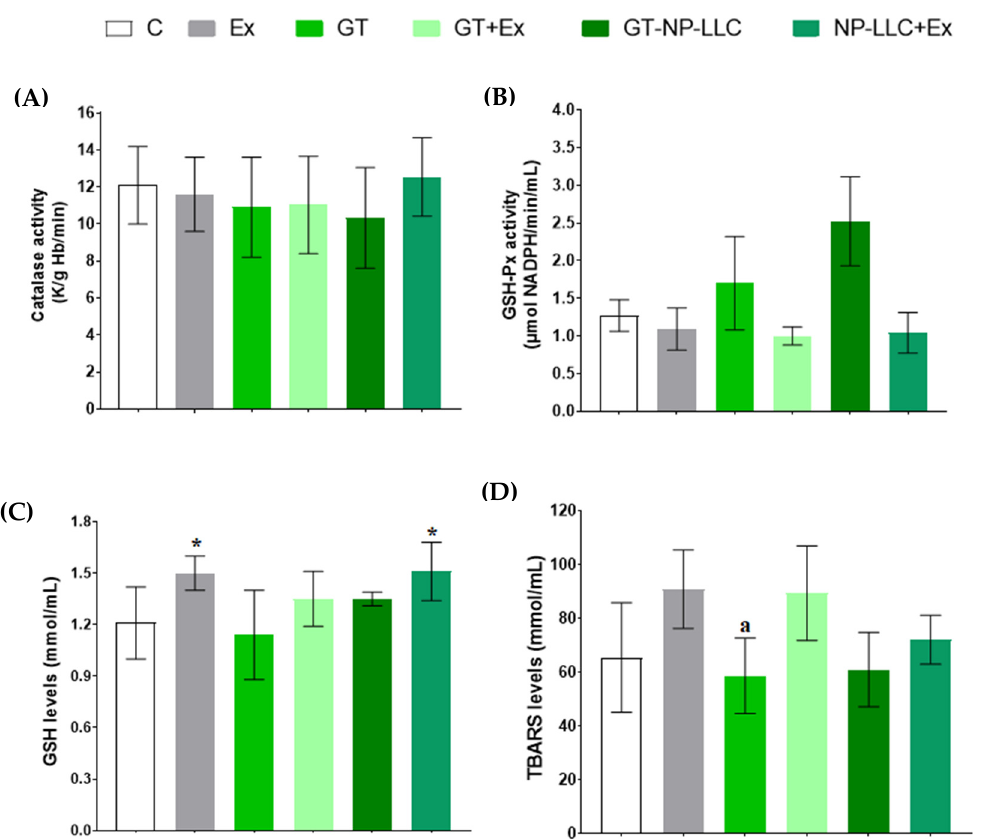
Figure 3. Redox state represented by Catalase ( A ), Glutathione Peroxidase (GSH-Px) ( B ), Reduced Glutathione (GSH) ( C ), Thiobarbituric Acid Reactive Substances (TBARS) ( D ). Note: Mean ± SD * p < 0.05 when compared to Control. a p < 0.05 when compared to Ex.